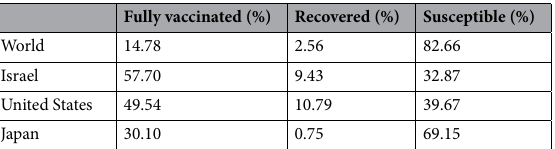
Table 1. Vaccinated, recovered, and susceptible for the World and selected countries as of August 3,